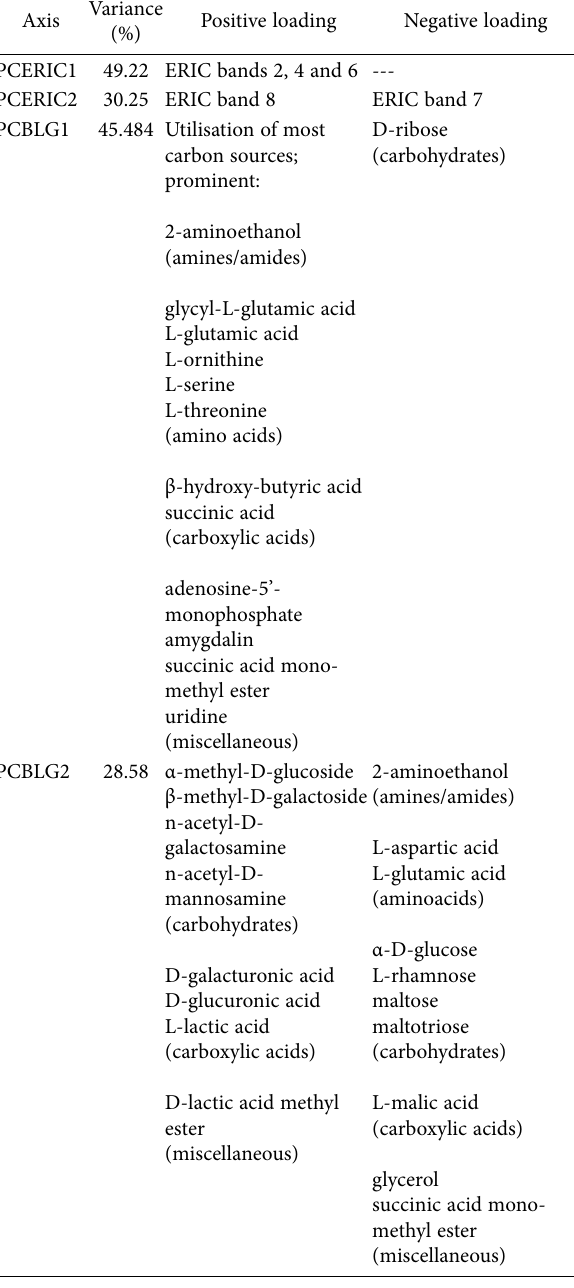
Table 2. Synthetic gradients generated by Principal Component Analysis of molecular and metabolic profiling of Pochonia chlamydo- sporia